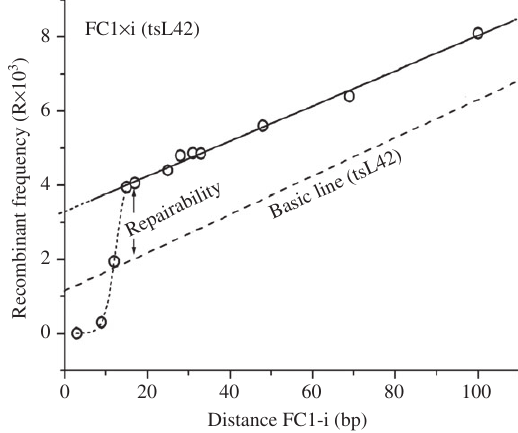
Figure 6 Measuring the repairability value and repair tract length in tsL42 background (48)